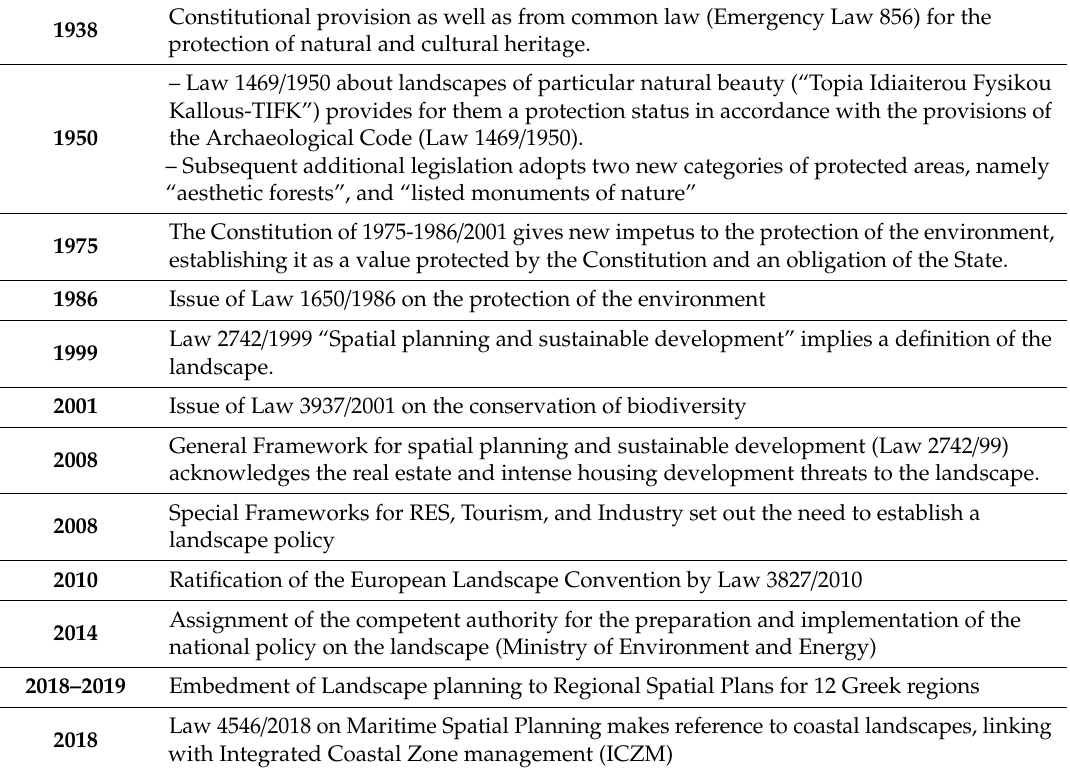
Table 4. Milestones related to the integration of landscape planning in the Greek legal system. Source: authors’ own